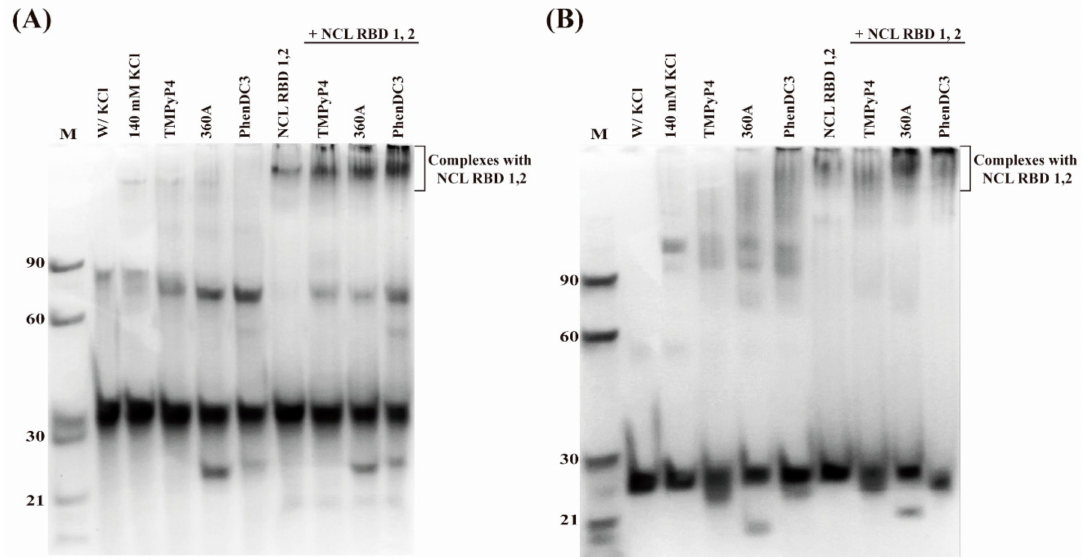
Figure 11. Polyacrylamide gel electrophoresis under native conditions of ( A ) AS1411-N6 and ( B ) AS1411. The gel was supplemented by 140 mM KCl. Migration markers were oligothymidylate single-stranded DNA (n = 21, 30, 60 and 90). Lane 1—migration marker; lanes 2 and 3—aptamer in the absence and presence of KCl; lanes 4 to 6—aptamer/ligand complexes (with 1 molar eq. of TMPyP4, 360A and PhenDC3, respectively); lane 7—aptamer with NCL; lanes 8 to 10—aptamer/ligand complexes (at same order) with